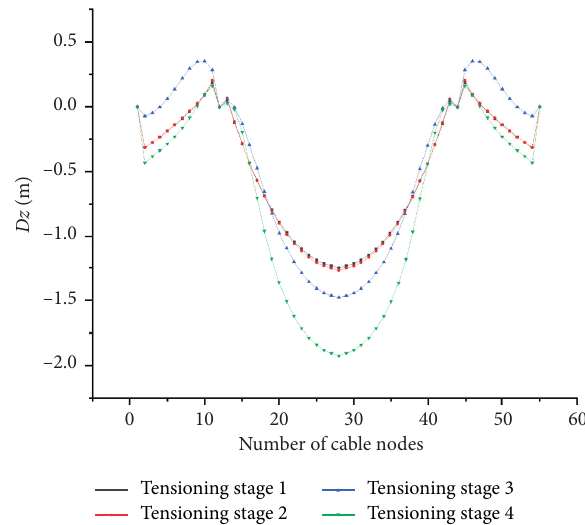
Figure 9: Vertical displacement change of the main cable for each stage.